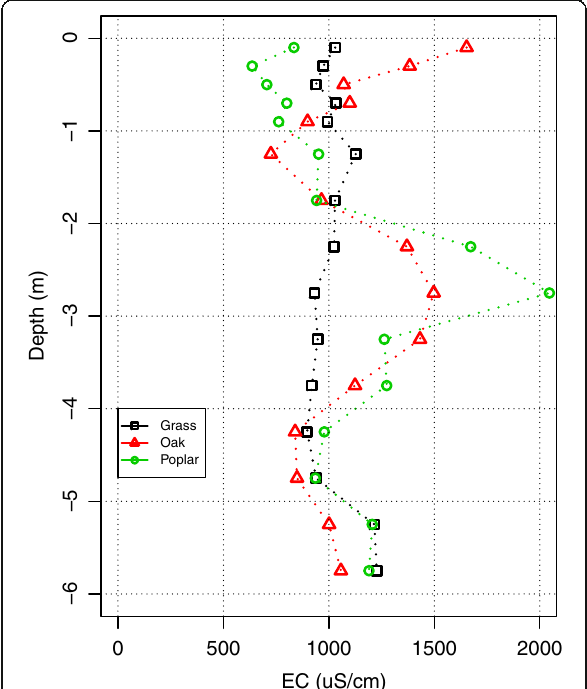
Fig. 8 Electrical conductivity (EC) profile of reference saturation extract under the pasture, the oak forest and the poplar